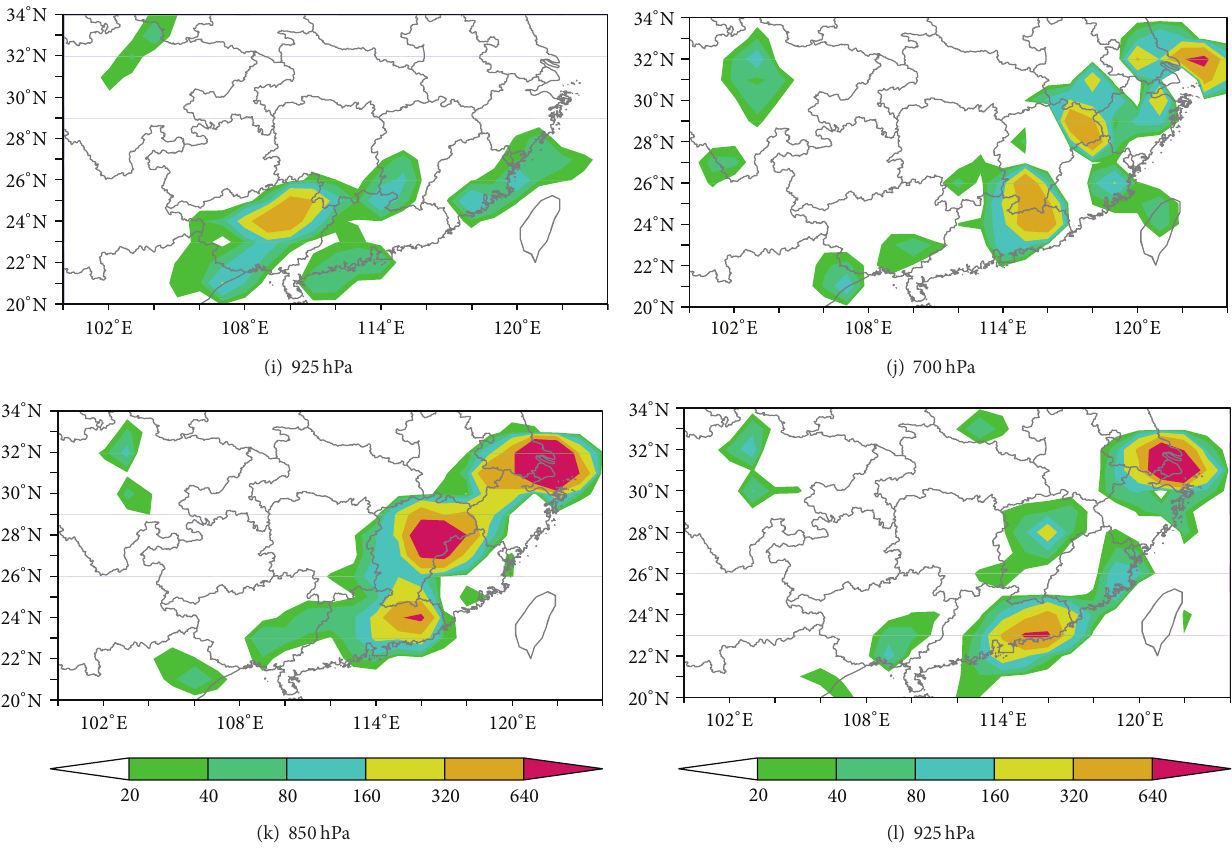
Figure 14: Distribution of moist helicity divergence (shaded in 10 −11 Pa/s 3 ) at 700 hPa, 850 hPa, and 925 hPa averaged over (a), (b), and (c): 12 UTC, June 10-00 UTC, June 11; (d), (e), and (f): 00 UTC, June 11-00 UTC, June 12, (g), (h), and (i): 00 UTC, June 12-00 UTC, June 13; and (j), (k), and (l): 00 UTC, June 13-00 UTC, June 14,